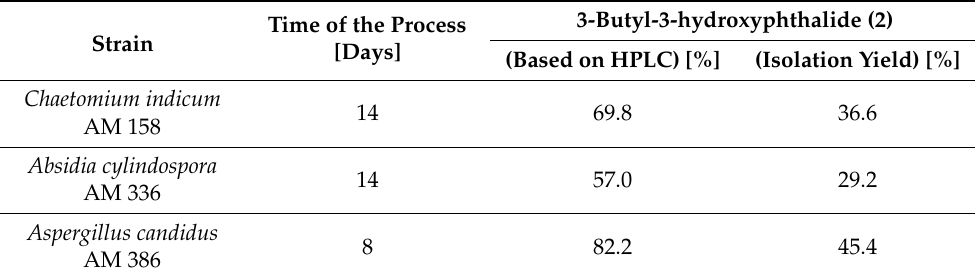
Table 1. Product ( 2 ) content in the biotransformation mixtures at the end of the processes both before and after isolation. Time of the Process Strain [Days]